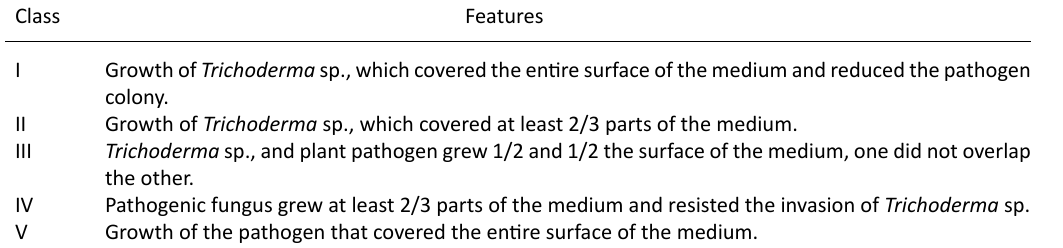
table 1. Bell 15 antagonism scale